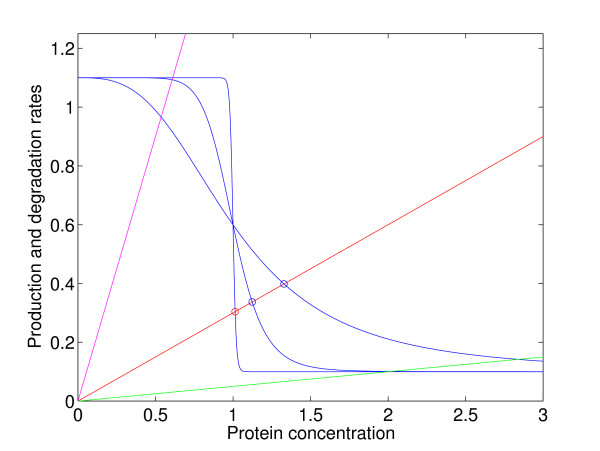
Graphical solution of the equilibrium condition of Eq. (2) for varying steepness of the response function and varying relative degradation rates. The blue curves are graphs of r + α(1 - Z), the straight lines graph the degradation term γy. For intermediate values of γ the equilibrium concentration is close to θ and approaches θ when the response function steepness increases (red line), and there is active regulation. When γ is small, the basal transcription rate is sufficient to balance the degradation, and y* gets large (green line). When γ is large, degradation is so rapid that the protein concentration never reaches the level where it regulates. Maximal production is necessary to balance the degradation (magenta line).